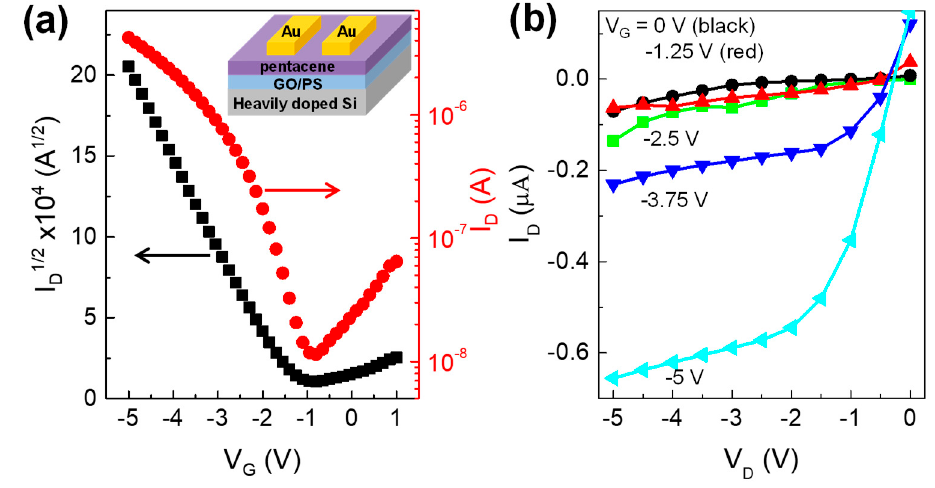
Figure 6. ( a ) Transfer and ( b ) output characteristics of OFET with GO/PS bilayer dielectric under a single sweep mode ( V G = 0, − 1.25, − 2.5, − 3.75, and − 5 V from black circles to cyan triangles). The inset in (a) shows a schematic of the device structure used in this study.